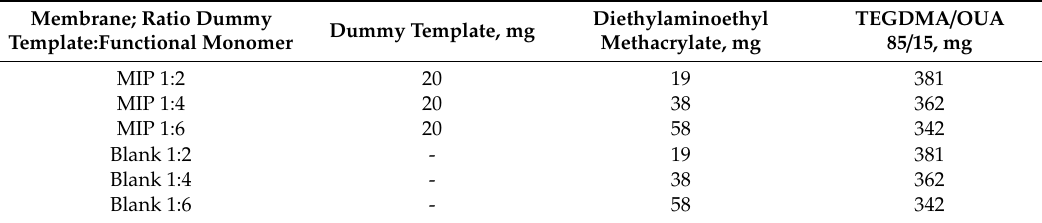
Table 2. Mixture of monomers used for the synthesis of diethylaminoethyl methacrylate-containing MIP and blank polymeric membranes capable of zearalenone binding. *